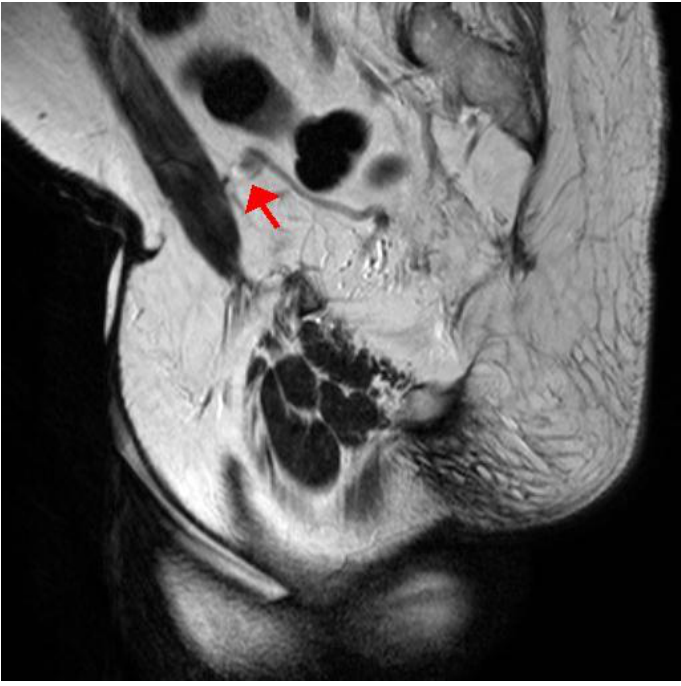
FIGURE 4. T-2 weighted sagittal image at the level of right ureter showing the right vas deferens crossing it